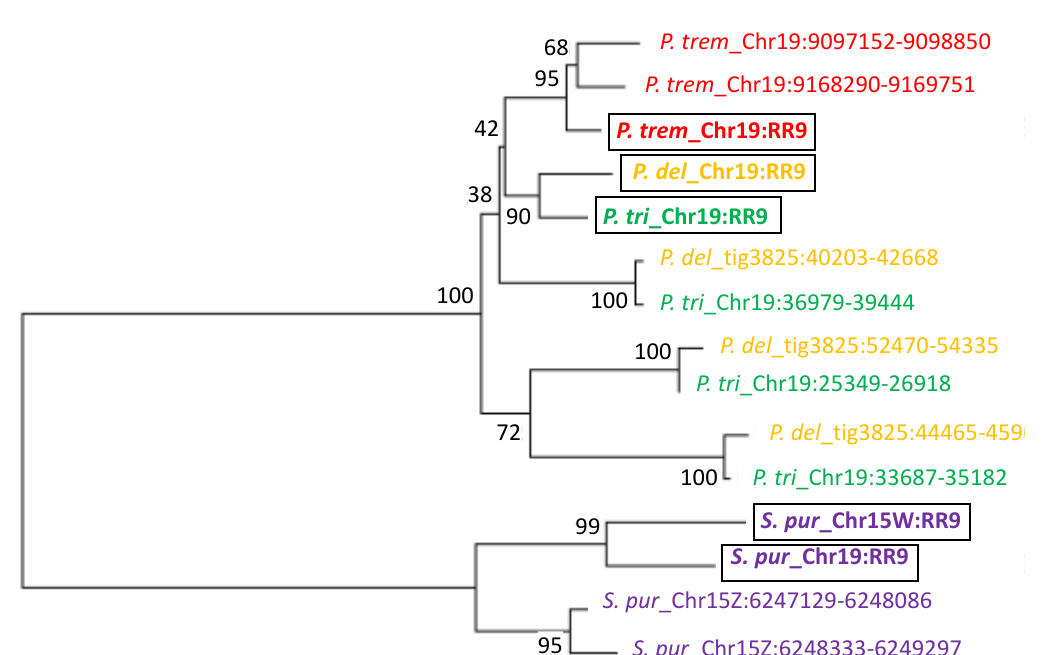
Figure 7. Phylogenetic relationship of homologous PtRR9 fragments. A neighbor-joining tree was constructed based on sequence alignment of homologous portions of the ARR17 gene ( RR9 ) in P. deltoides ( P. del ), P. tremula ( P. trem ), P. trichocarpa ( P. tri ), and S. purpurea ( S. pur ). Species are color-coded. RR9 represents the full-length gene (bold, boxed). The genomic position is indicated after the underscore, where Chr represents a chromosomal scaffold, tig represents an unplaced contig, and positions of the inverted repeat fragments are indicated after the chromosome or contig identifier.